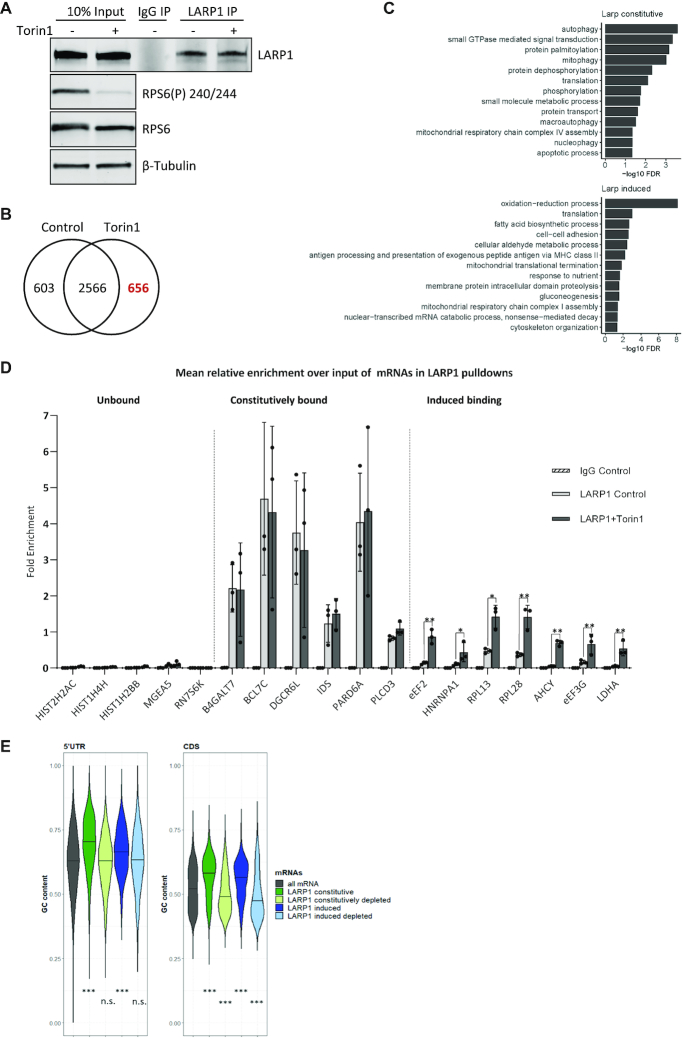
mRNAs associated with LARP1 with and without mTOR inactivation. HeLa cells were serum stimulated followed by control or Torin1 treatment. Endogenous LARP1 immunoprecipitation was performed and beads split for analysis of RNA and proteins. (A–C) mRNA arrays were performed using RNA extracted from both input and LARP1 pulldowns in control and mTOR inhibited conditions. The experiment was performed four times independently. (A) Western blots of endogenous LARP1 immunoprecipitates and 10% input samples from one representative experiment using indicated antibodies. (B) Number of RNAs significantly enriched over input in LARP1 IPs (Control log FC > 0.5 & Torin1 log FC > 0.5). (C) Genes uniquely assigned to either the induced or constitutively bound groups were assessed for enrichment of gene ontology biological process (BP) terms using David functional annotation. The graphs present terms enriched with an FDR < 0.05. (D) qPCR validation of RNA enrichment over input using primers for indicated RNAs, expressed as mean relative enrichment in LARP1 pulldown over input. mRNAs defined as unbound, constitutively bound or induced bound to LARP1 as described in main text. Paired 2-tailed t test on the means of three independent experiments. (E) Analysis of the GC content of 5′UTR and CDS sequences of all RefSeq mRNAs and LARP1 bound mRNAs. The term constitutively depleted refers to mRNAs that are significantly depleted (LogFC > –0.5) in both control and mTOR inhibited conditions and ‘induced depleted’ refers to mRNAs that are unbound in control conditions (FDR > 0.05) and depleted (log FC < –0.5) in Torin1-treated conditions. Medians indicated by black lines and statistical significance calculated using Kruskal-Wallis followed by Dunn test.